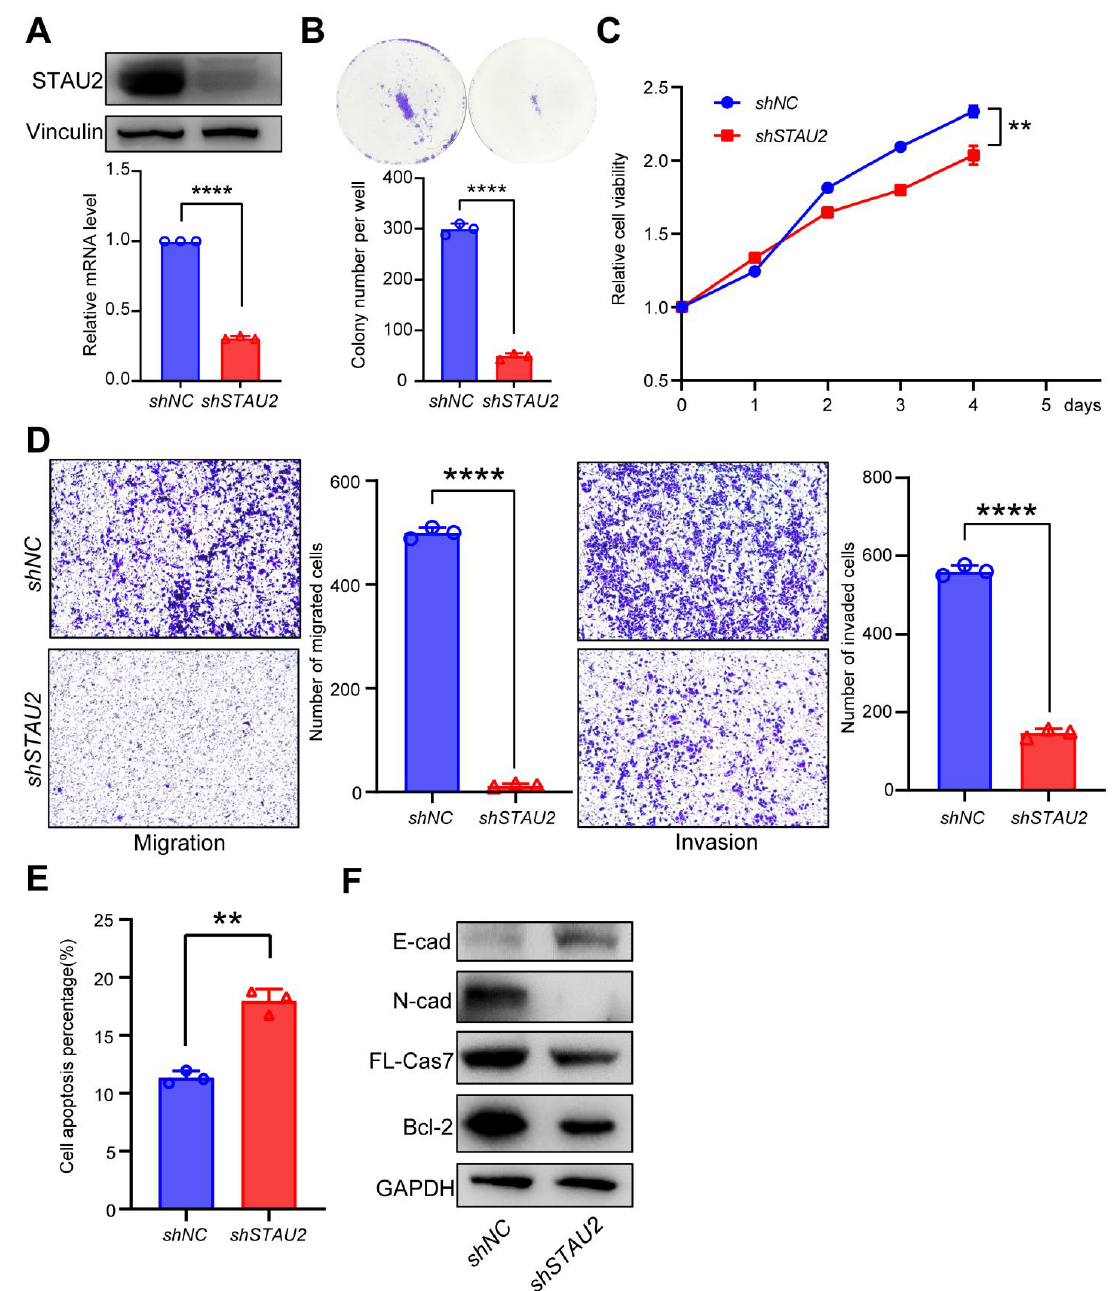
Figure 5. Functional analysis of STAU2 gene downregulation in pancreatic cancer. ( A ) Western blot analysis of STAU2 protein levels in vector-transfected shSTAU2 or PANC-1 cells. Vinculin was used as an endogenous control. The uncropped Western Blot images can be found in Figure S8. ( B – D ) The effect of knocking down the STAU2 gene on colony formation ( B ), cell growth ( C ), migration ( D ), left, cells stained with crystal violet were cells migrating to the low surface), and invasion ( D ), right, crystal violet stained cells invading through Matrigel to the low surface) in PANC-1 cell lines. ( E ) Representative flow cytometry plot for quantifying apoptosis in PANC-1 STAU2 KD and control cells. ( F ) Western blot analysis of protein changes associated with cell migration, invasion, and apoptosis following STAU2 knock-down. Statistical analysis of the results of the above three inde- pendent experiments was performed using the unpaired Student’s t -tests: ns p > 0.05, ** p < 0.01, **** p <0.0001. Error Bar, mean ± SD, n = 3. The uncropped Western Blot images can be found in Figure S9.